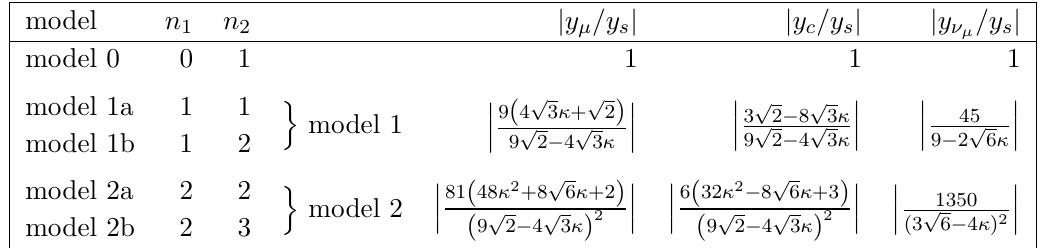
, 16 , 45 and 10 by q 2 3 and O demands 33 22